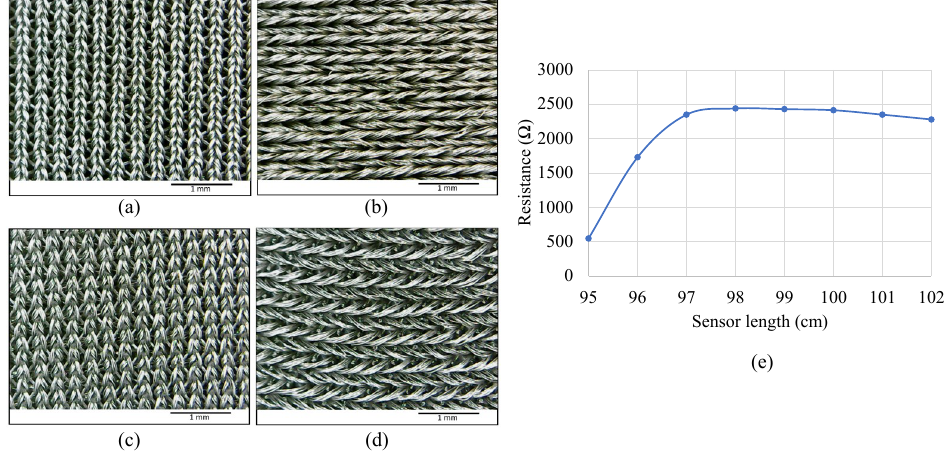
Figure 2. Sensor fabric and strain–resistance curve. ( a ) Unstretched front view, ( b ) unstretched back view, ( c ) stretched front view, ( d ) stretched back view, and ( e ) sensor stretch vs resistance measurement showing a nonlinear